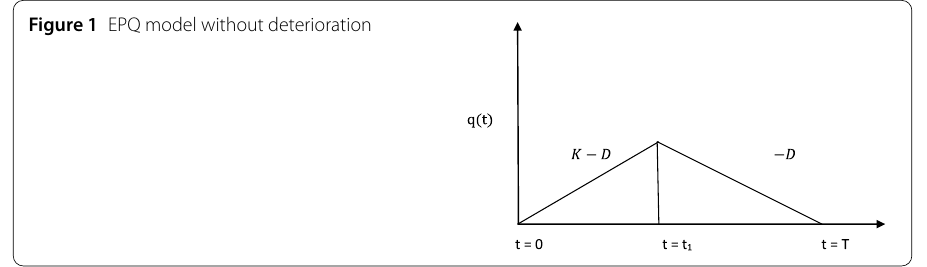
Figure 1 EPQ model without